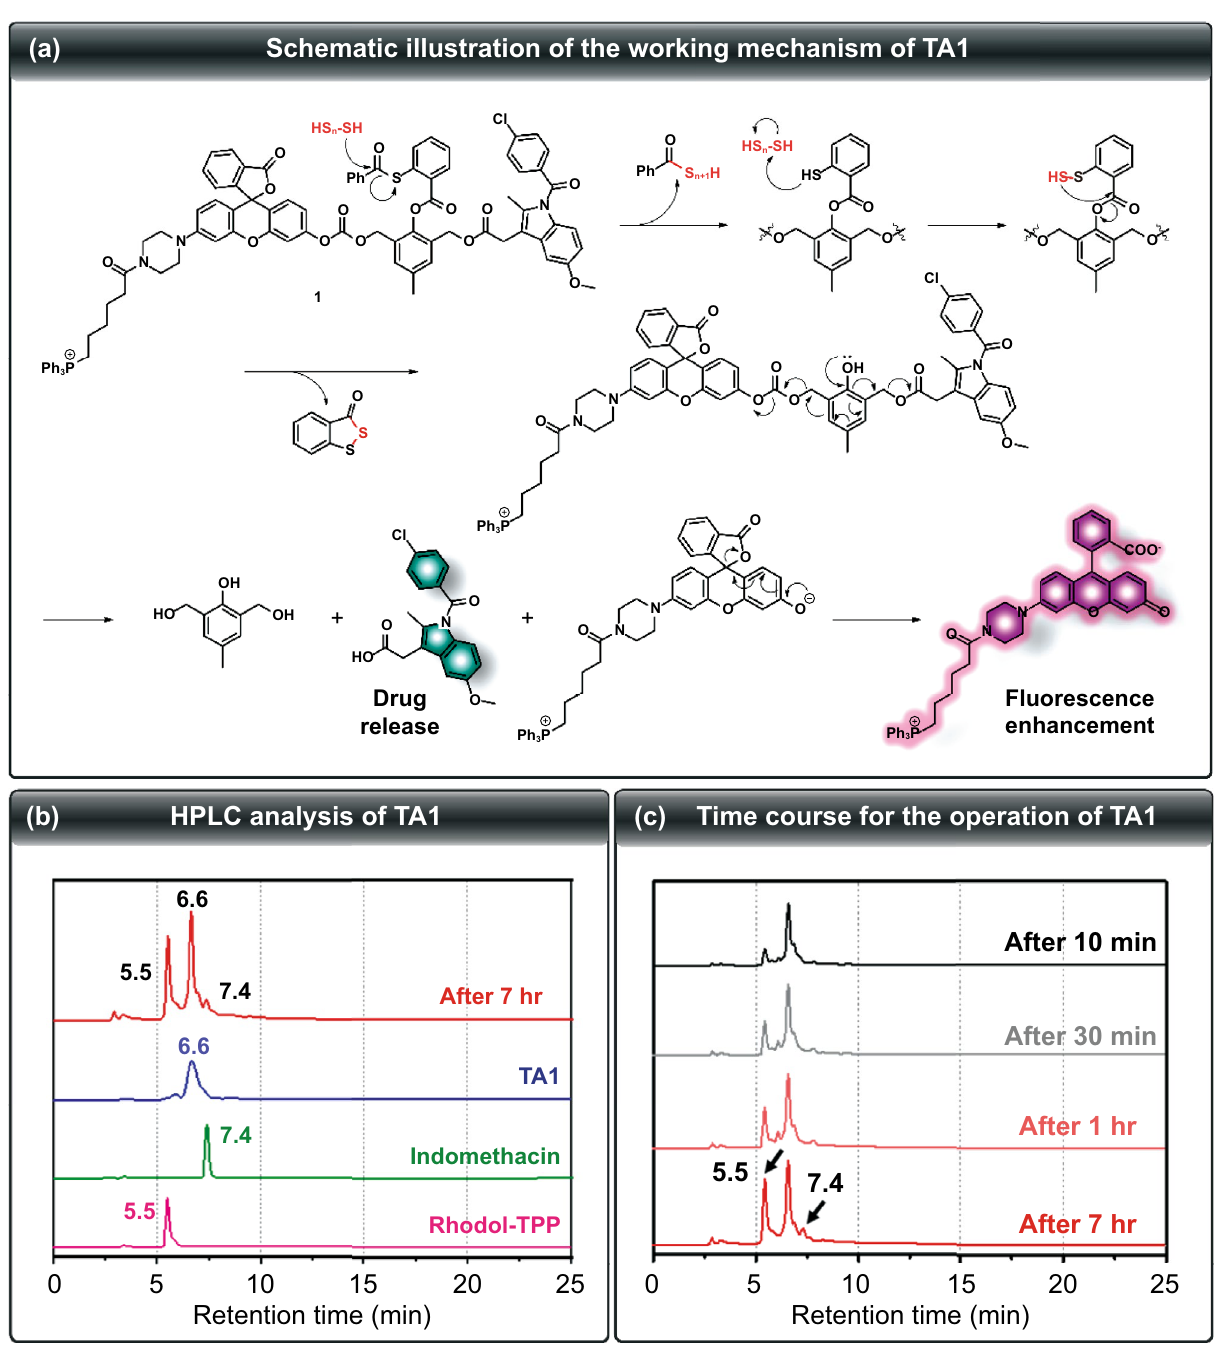
Fig. 2 a Schematic illustration of the working mechanism of TA1 . b HPLC chromatogram of TA1 (blue line), indomethacin (green line), Rho- dol-TPP (pink line), and the reaction mixture of TA1 with Na 2 S 3 (red line). c Time-dependent change of HPLC chromatogram of the reaction mixture of TA1 with Na 2 S 3 . (COlor figure